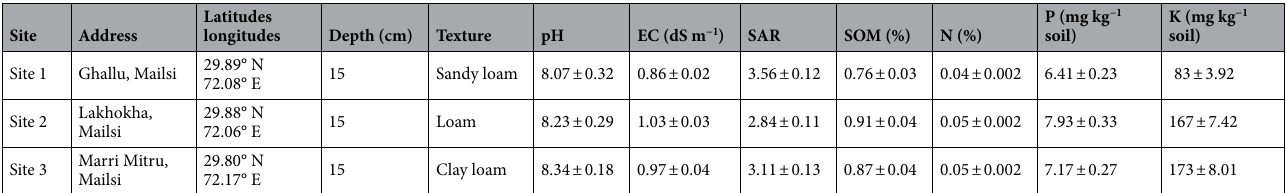
Table 2. Soil physico-chemical properties of the experimental sites. All the values means ± S.E of three